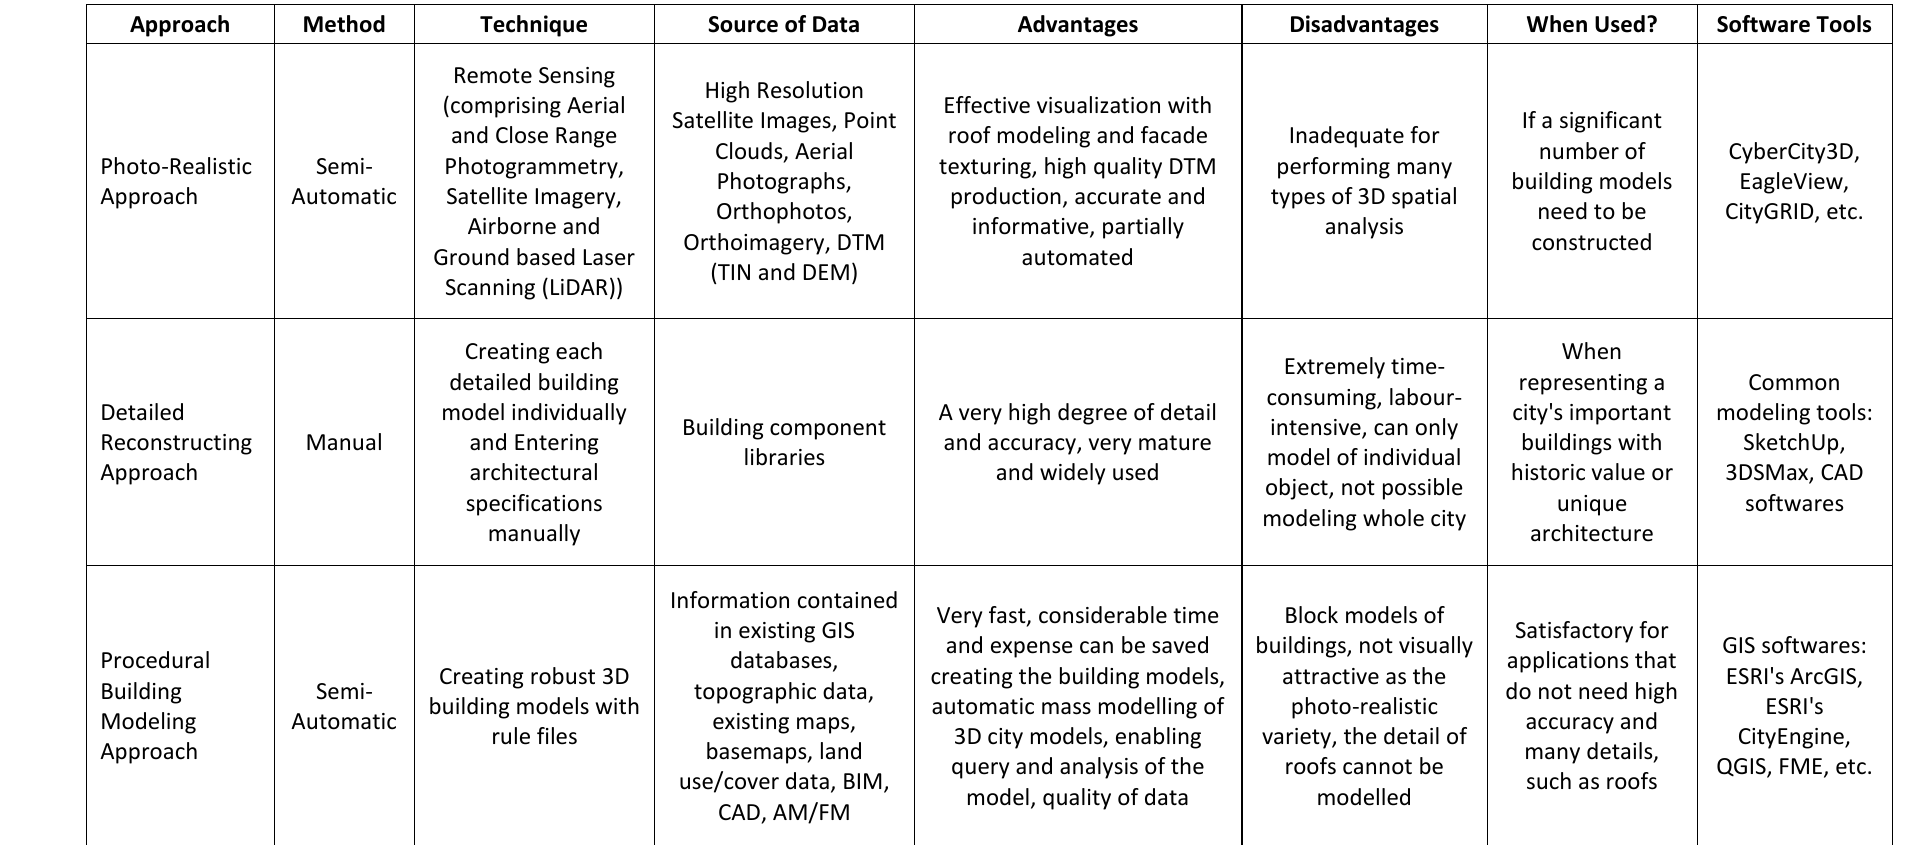
Figure 1. Three level architecture for the 3D geospatial applications on the web